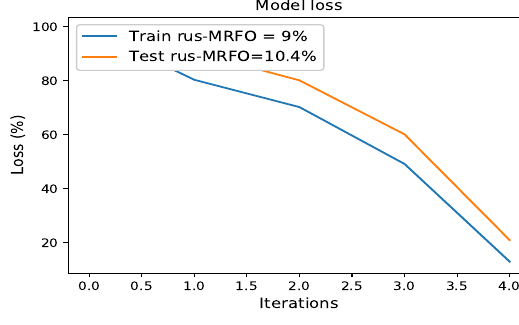
Figure 10. Loss rus-MRFO.